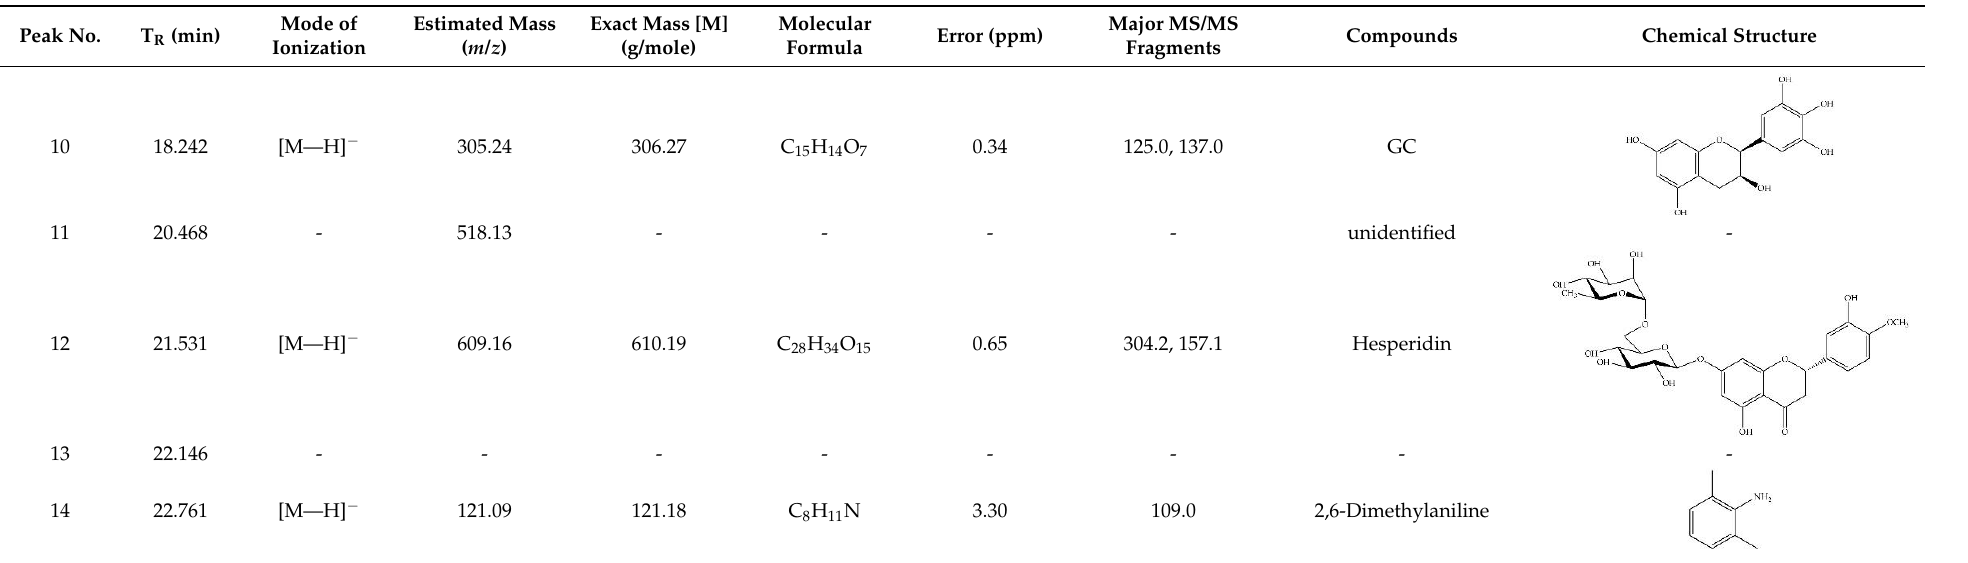
For the purposes of calibration, different concentrations of mixed standard phenolics (10 μL) were injected into the HPLC system to indicate the relative phenolic compounds present in the extract eluted from the column and to establish the standard curves needed to calculate the appropriate concentrations. In our findings, the standard GA, C, EGCG, EC, ECG, CO and Q quantities came out at specific T R values of 7.02, 12.27, 14.00, 15.40, 17.28, 21.27 and 26.48 min, respectively. Correspondingly, GA, catechin (C), epicatechin 3-gallate (ECG), coumarin (CO) and Q were detected in the ethanolic extract of P. odoratum Lour . cv. Pakphai leaves (Figure 2A), while epigallocatechin 3-gallate (EGCG) and EC were not detected (Figure 2B). Accordingly, concentrations of the five phenolics were de- termined from the standard curves and have been expressed in Table 2, of which Q was the most abundant and ECG was the second most abundant.